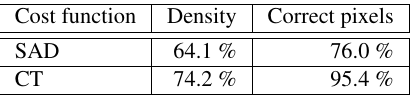
Table 3. Quantitative results achieved by our algorithm for dis- parity estimation w.r.t. to the KITTI Stereo 2015 benchmark, de- pending on the similarity measure used. A pixel is considered to be estimated correctly if the disparity < 3px w.r.t. to the ground truth. The density specifies percentage of pixels in the resulting disparity image for which the disparity was computed.